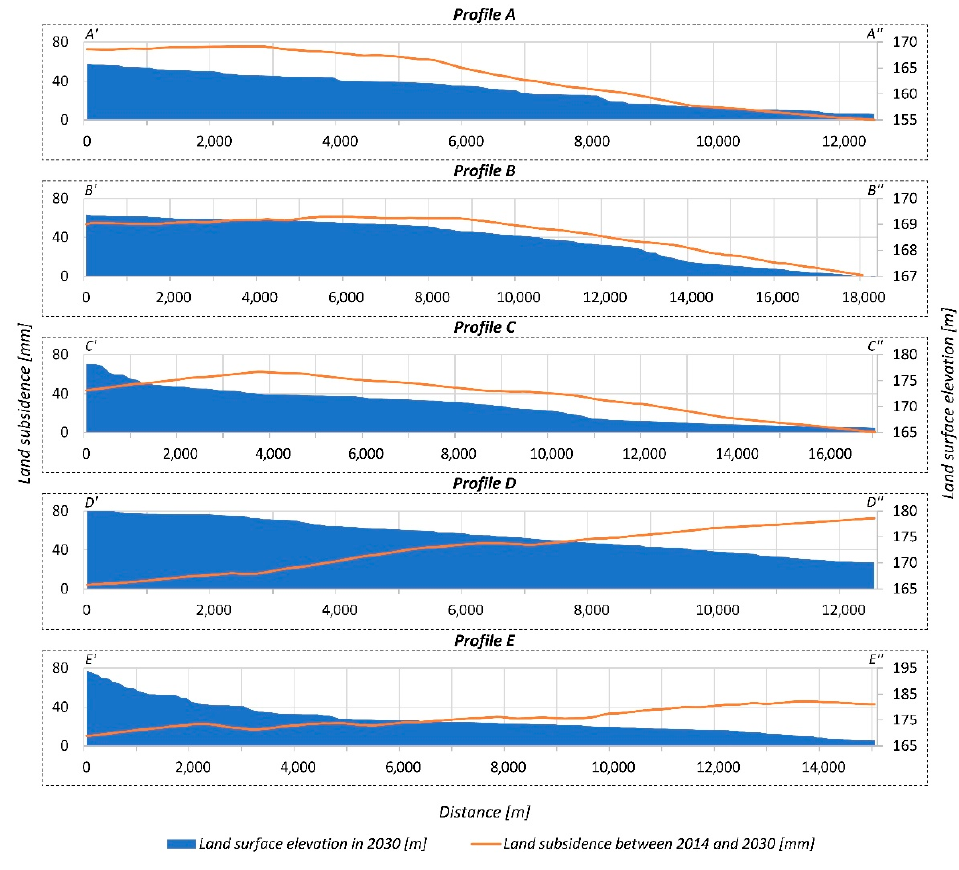
Figure 13. Profiles of surface elevation in 2030 and drainage-related land subsidence between 2014 and 2030 for selected ( A – E ) watercourses; see Figure 12 for profile location; A ′ -E ′ and A ″ -E ″ points mark the start and endpoints of selected profiles, respectively.